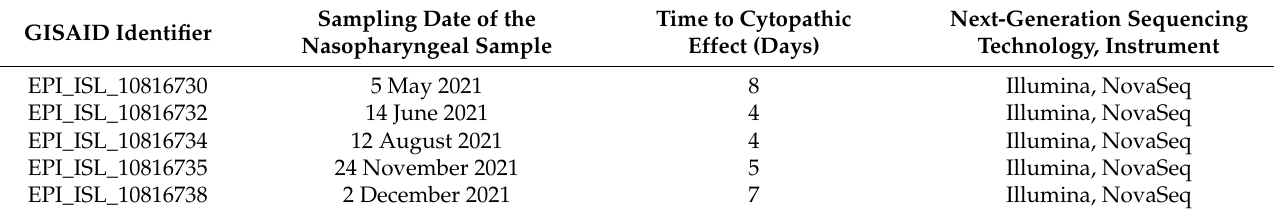
Table 2. Genome sequences obtained from the culture